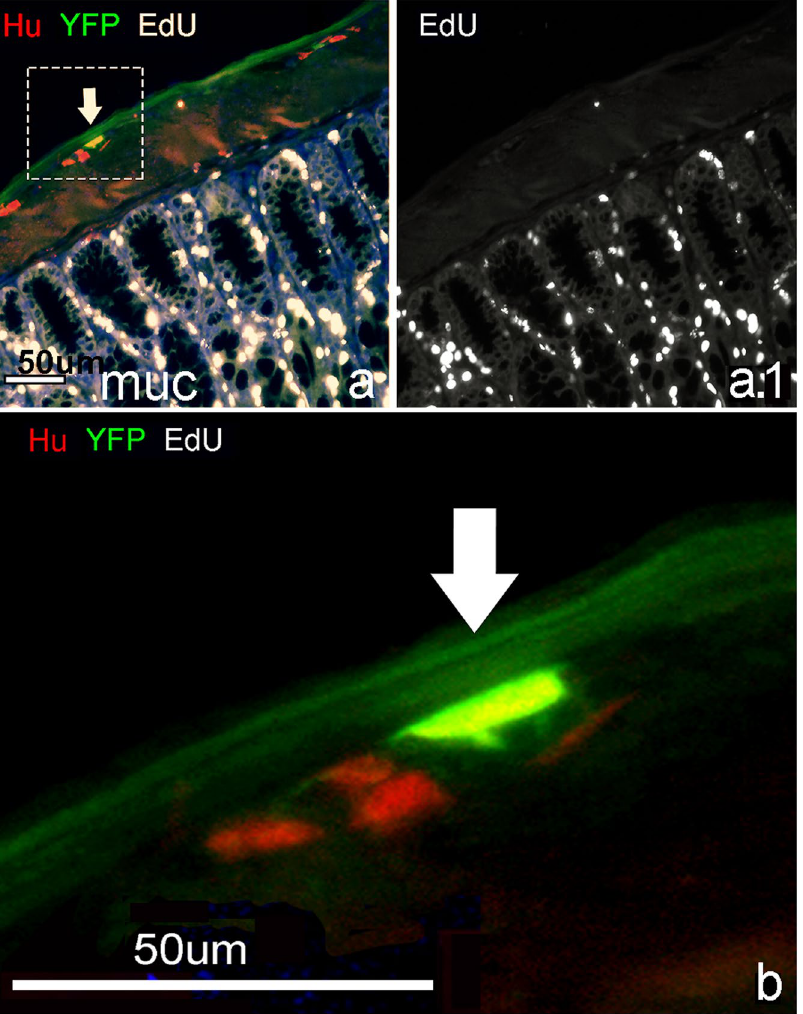
Figure 4. Glia give rise to neurons without new DNA synthesis. EdU was administered i.p. daily (50 mg/Kg) to Sox2creER:YFP mice receiving DSS for 7 days and examined 2 days later. EdU incorporation was seen in the mucosa (muc a, a.1), but not in Hu + or Hu + YFP + neurons (arrow). ( b ) Magnified view of myenteric ganglia. (Fig. 4 was taken at 200X, except closeup magnification 4. b